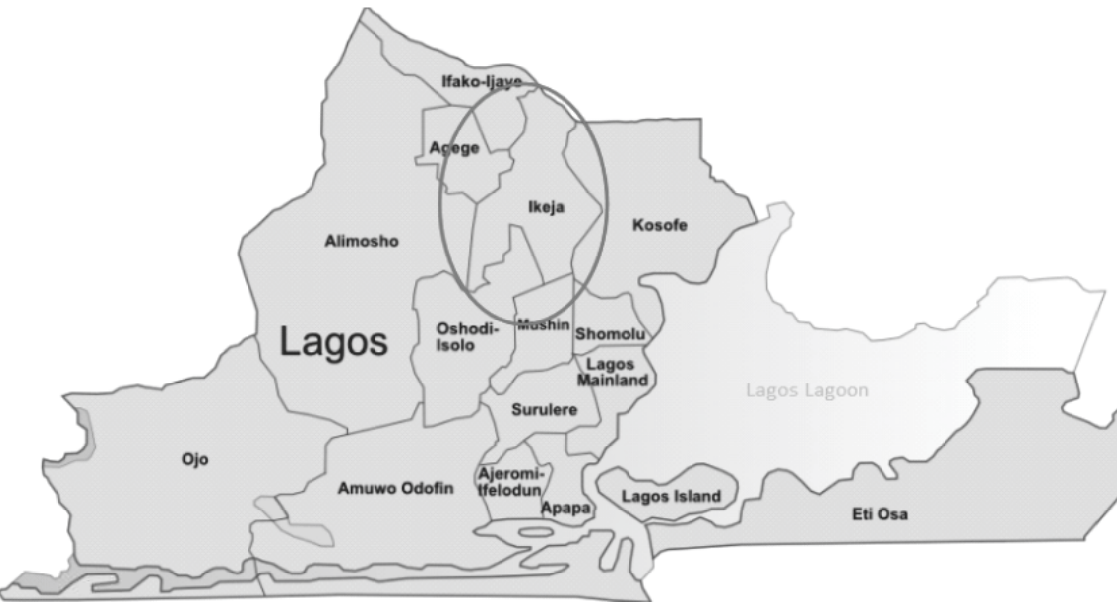
Fig. 5. Map of Lagos State, showing sixteen of the existing twenty Local Governments in Metropolitan Lagos; Ikeja Local government in oval circle 14